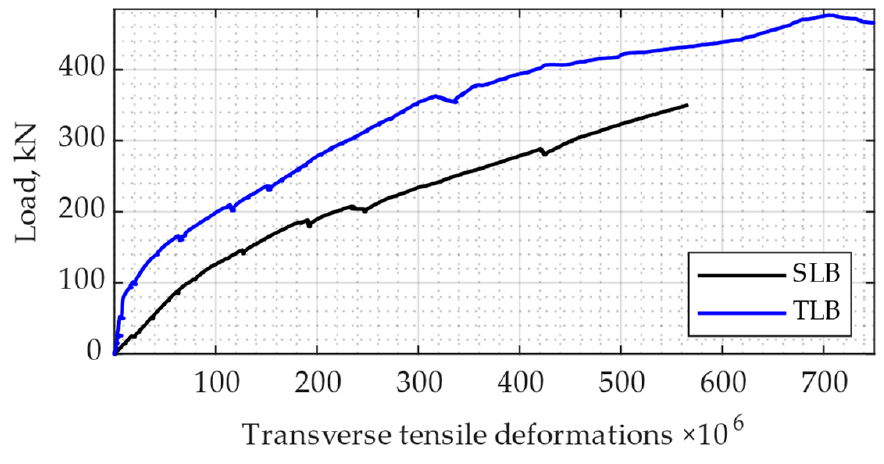
Figure 6. Typical load–transverse deformation diagram. 5.2. Development of Transverse Deformation Theory Based on the Obtained Experimental Results The relationships between the transverse and longitudinal deformations in the SLB and TLB are presented in Figure 7. The dependence between these deformations was a concave curve; i.e., as the longitudinal deformations became higher, the transverse ones grew in a non-linear form. According to the classical interpretation of Poisson deformations, there is linear relationship between the transverse and longitudinal deformations up to the elasticity limit. This concept corresponded with line 1 in the figure. Line 2 corresponded with the non-linear parts of the graphs and began from the longitudinal deformations